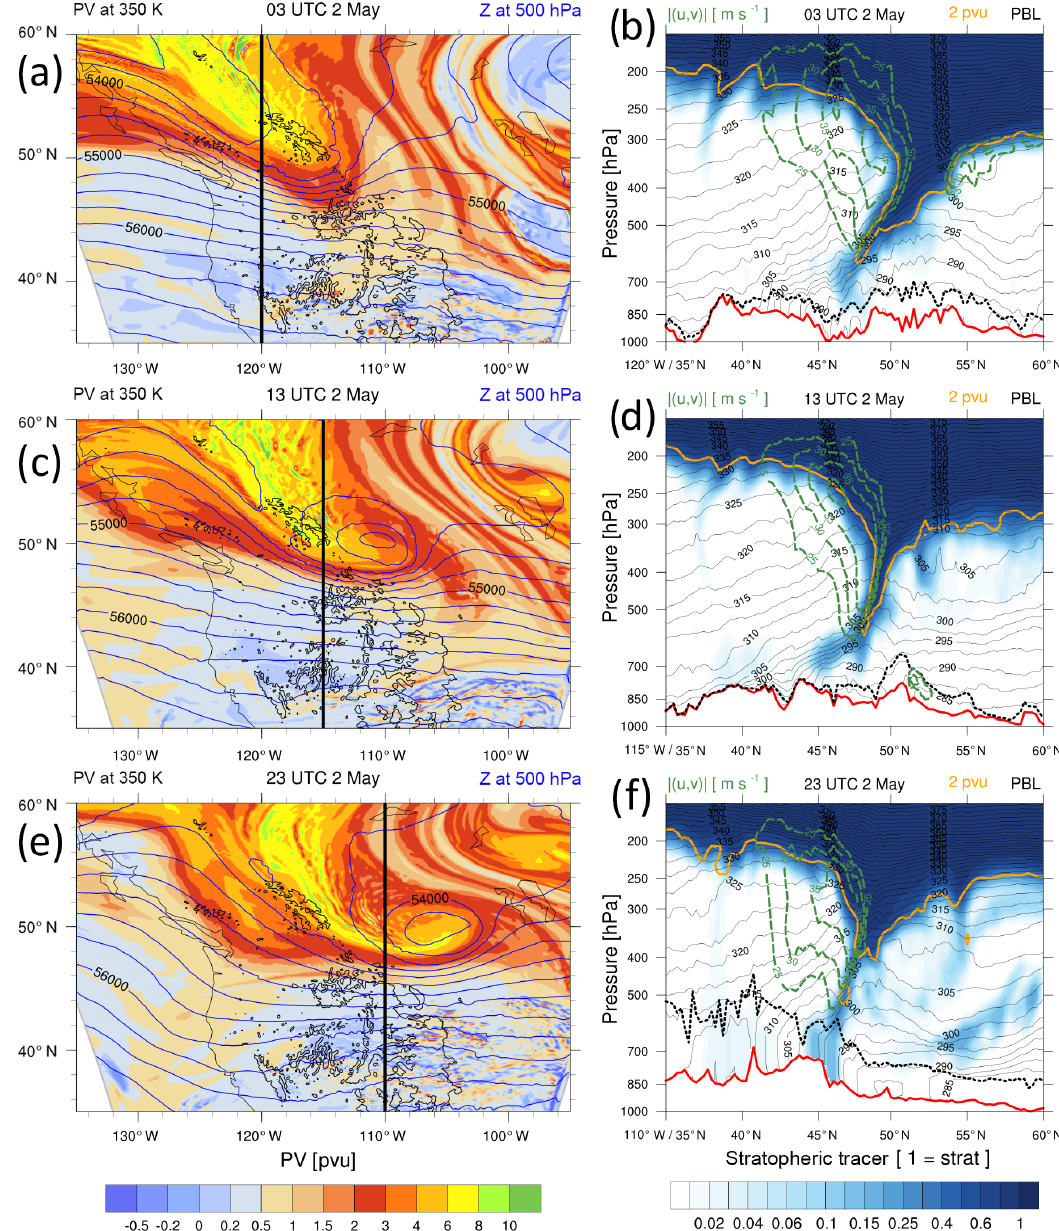
Figure 3. Left column: PV on 320K (in pvu, coloured) and geopotential height at 500hPa (blue contours, interval 250m) at (a) 03:00UTC on 2 May, (c) 13:00UTC on 2 May, (e) 23:00UTC on 2 May 2006. Right column: corresponding vertical sections across the tropopause fold from 35 to 60 ◦ N (see black line in left column). Shown are concentration of stratospheric tracer (blue colours; a value of 1 denotes purely stratospheric air, note the non-linear scale), horizontal wind speed (in ms − 1 , dashed green contours), 2pvu isoline (orange contour), isentropes (in K, thin black contours), PBL height (dashed black contour) and topography (thick red